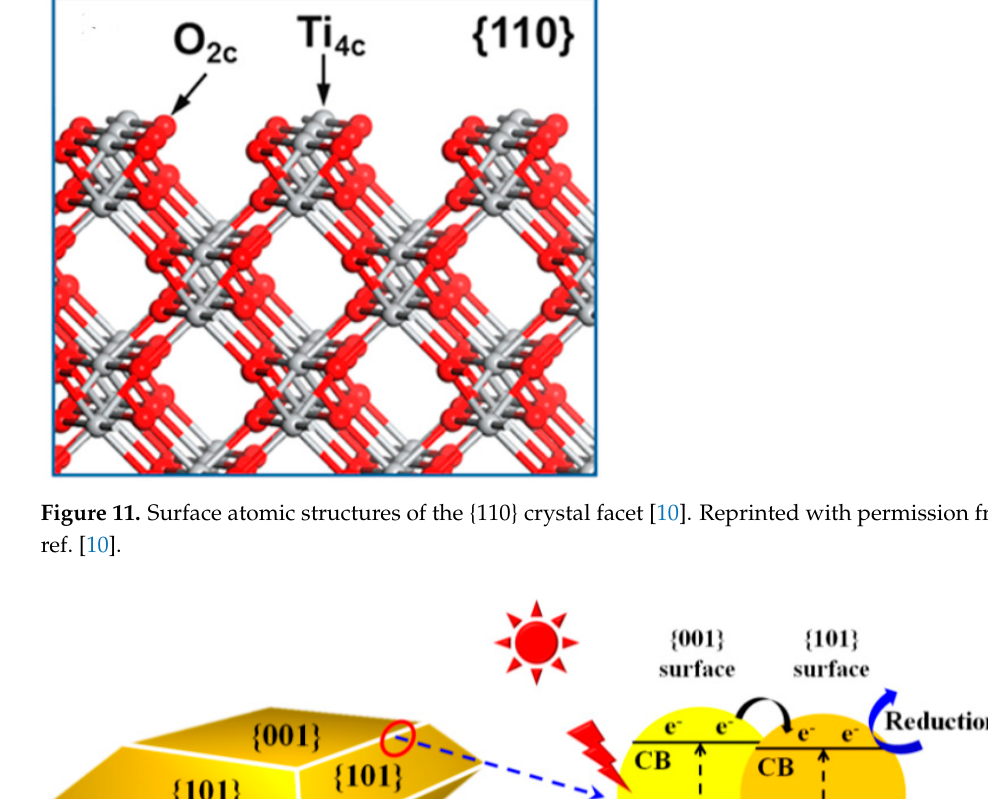
Figure 12. Mechanism of the surface heterojunction [46]. Reprinted with permission from ref. [46].